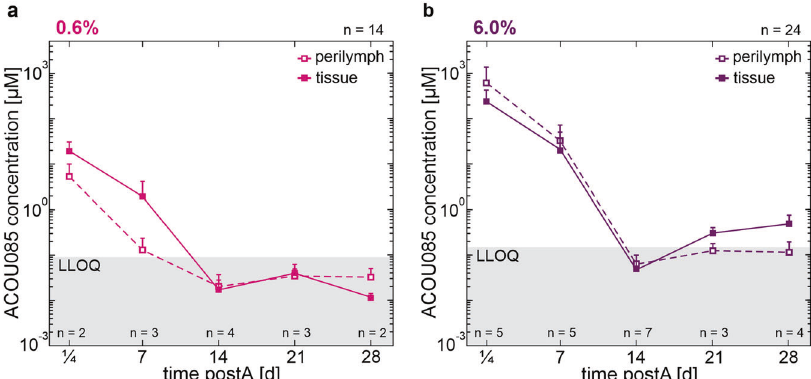
Fig. 2 Distribution of ACOU085 in the cochlea of SAMP8 mice after a single administration. Concentrations of ACOU085 in cochlear perilymph and tissue were determined by liquid chromatography with tandem mass spectrometry (LC-MS/MS). Mean and standard deviation of ACOU085 concentrations are shown for perilymph (open squares) and tissue (closed squares) sampling after a single administration of the 0.6% ( a ) or 6.0% ( b ) w/v ACOU085 formulation. The lower limit of quanti fi cation (LLOQ) was calculated for each timepoint taking dilution factors into account, with the mean LLOQ over all timepoints shown (gray